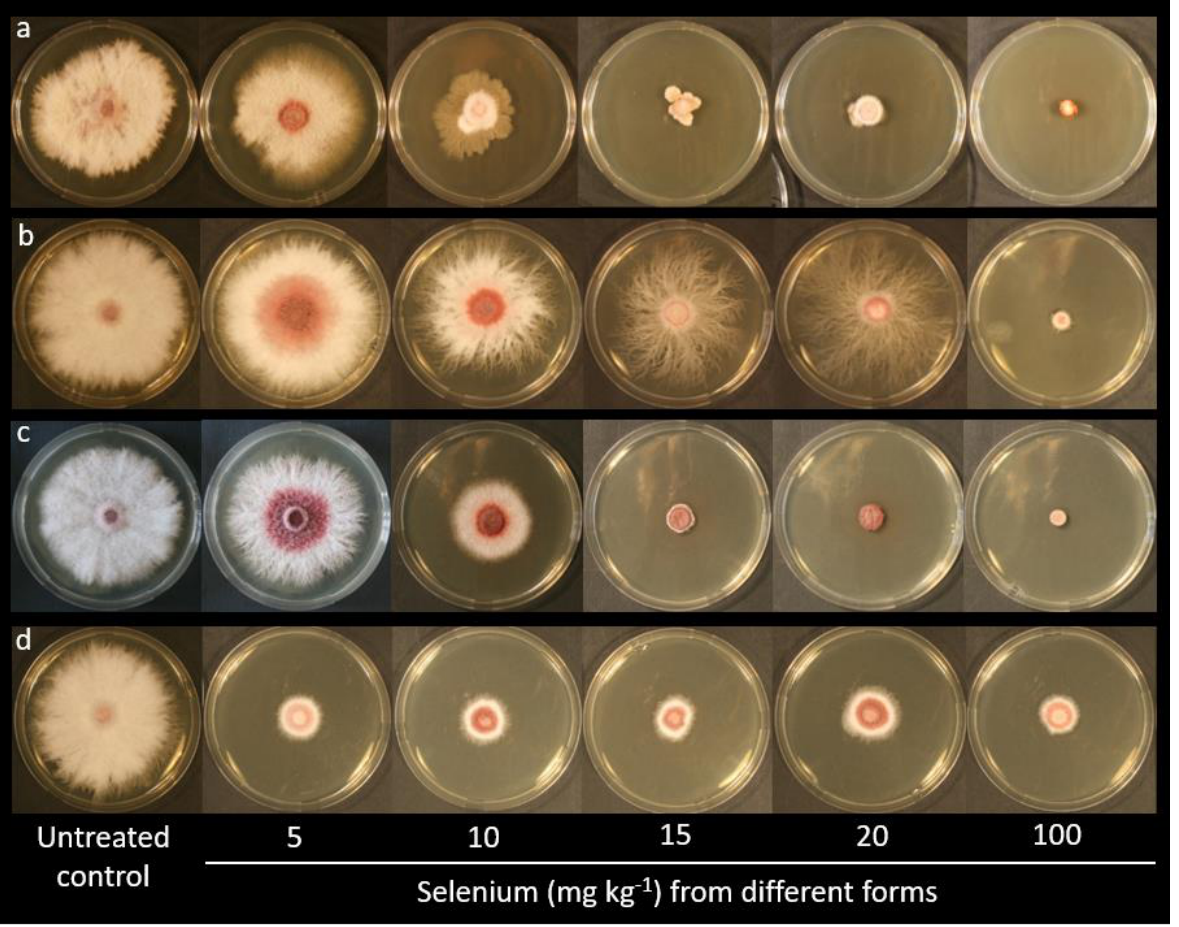
Figure 2. Effect of increasing selenium concentrations from different selenium forms on the colony development of Fusarium proliferatum strain PG – CH1 after 10 days of incubation at 22 ± 2 °C in the dark in comparison to the untreated control. Selenite ( a ), selenate ( b ), selenomethionine ( c ), selenocystine ( d ).